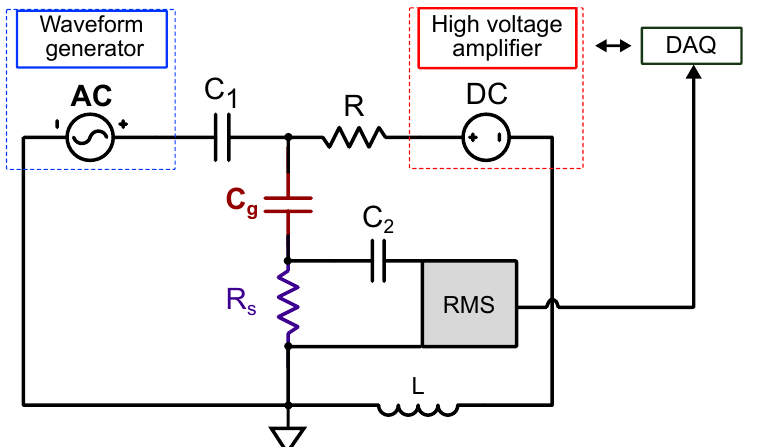
Figure 2. The capacitive sensing circuit.